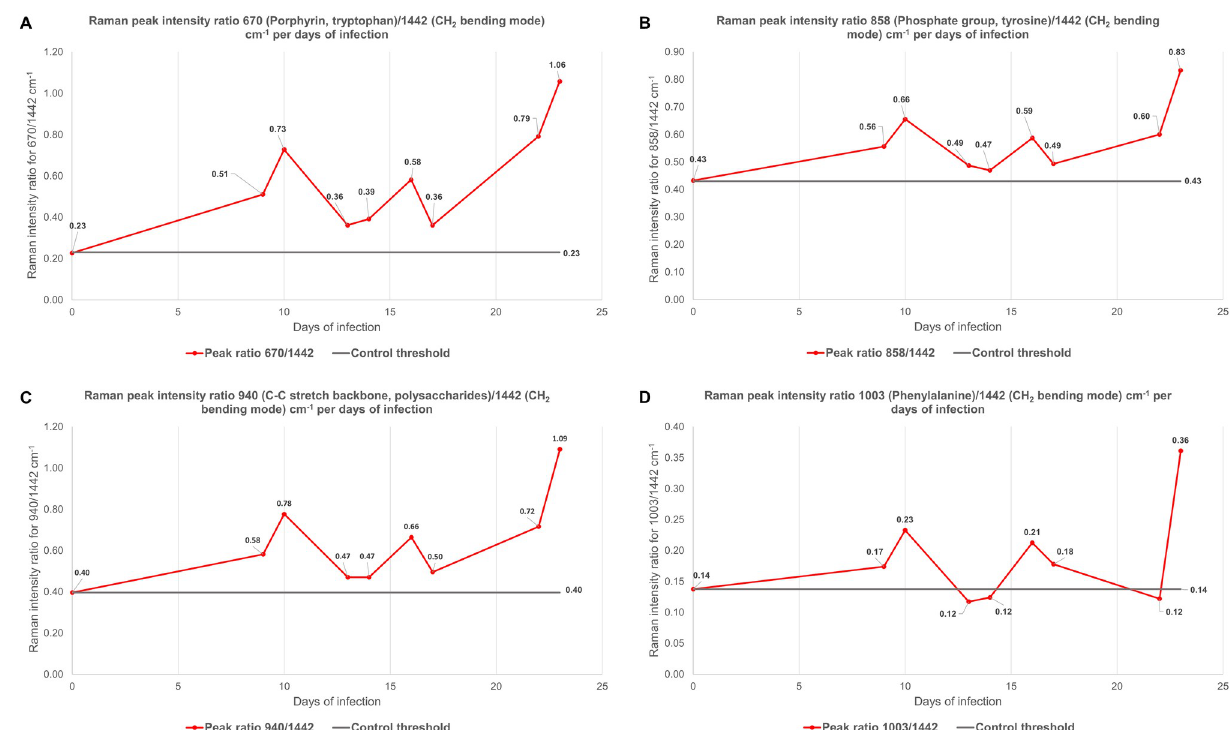
Fig 6. Graphs showing the evolution of the T . b . brucei infection in C57/black6J mice over the time course using a Raman peak intensity ratio. Four Raman peaks are displayed: (A) 670 cm -1 (Porphyrin, tryptophan) / 1442 cm -1 (CH 2 bending mode), (B) 858 cm -1 (Phosphate group, tyrosine) / 1442 cm - 1 (CH -1 (C-C stretch backbone, polysaccharides) / 1442 cm -1 (CH -1 (Phenylalanine) / 2 bending mode), (C) 940 cm 2 bending mode) and (D) 1003 cm 1442 cm -1 (CH 2 bending mode). The grey line corresponds to the Raman peak ratio averaged between both control murine and act as a threshold for the detection of the infection.